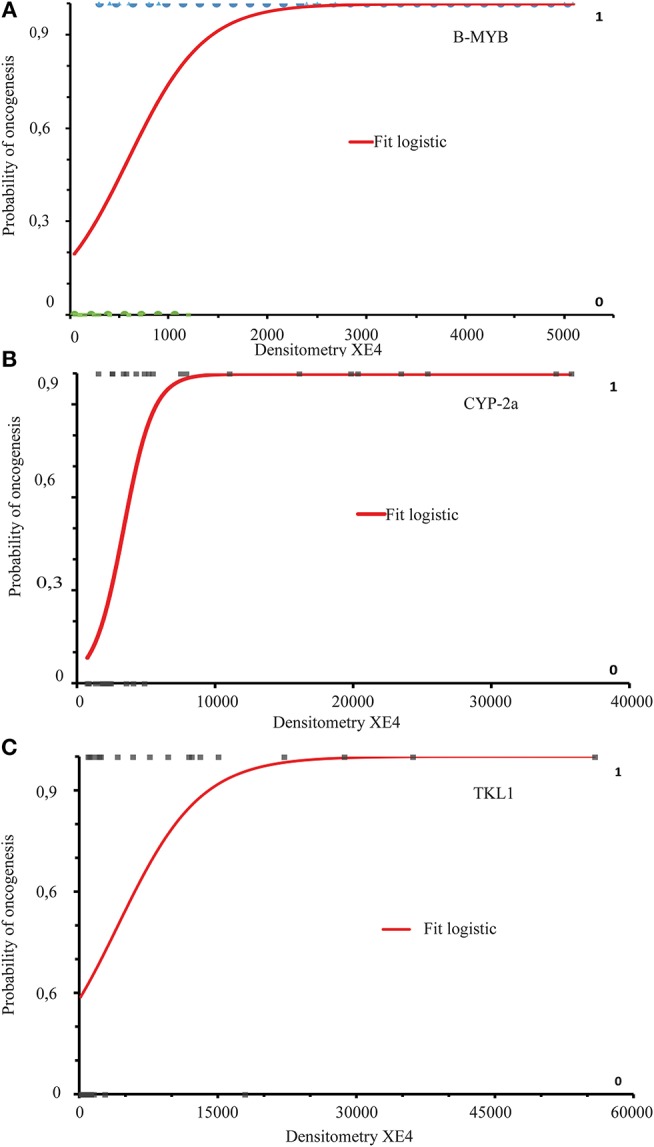
The three binary Logistic Regression curves reach convergence fitting the double-negative (or control) densitometric integrated intensity values with the double (LSIL/ASCUS and HR-HPV DNA)-positive values for each specific protein tested (A-C). The curves show the relationship in terms of Log Odd ratios between a categorical dependent outcome variable (“0” or normal vs. “1” or active oncogenesis) and the continuously increasing values of the predictor or independent variable, that is the specific band densitometry values of each protein studied. The binary Logistic Regression parameters (or coefficient) estimates of the three curves are reported in Table 4. The results of the Likelihood Ratio Tests (LRT or Effect of Model) (not shown here: see Table 5 for details) indicate a statistically significant impact of the increasing independent predictor (i.e., densitometry values) values on the dependent outcome “1” (i.e., ongoing HPV-driven oncogenesis).